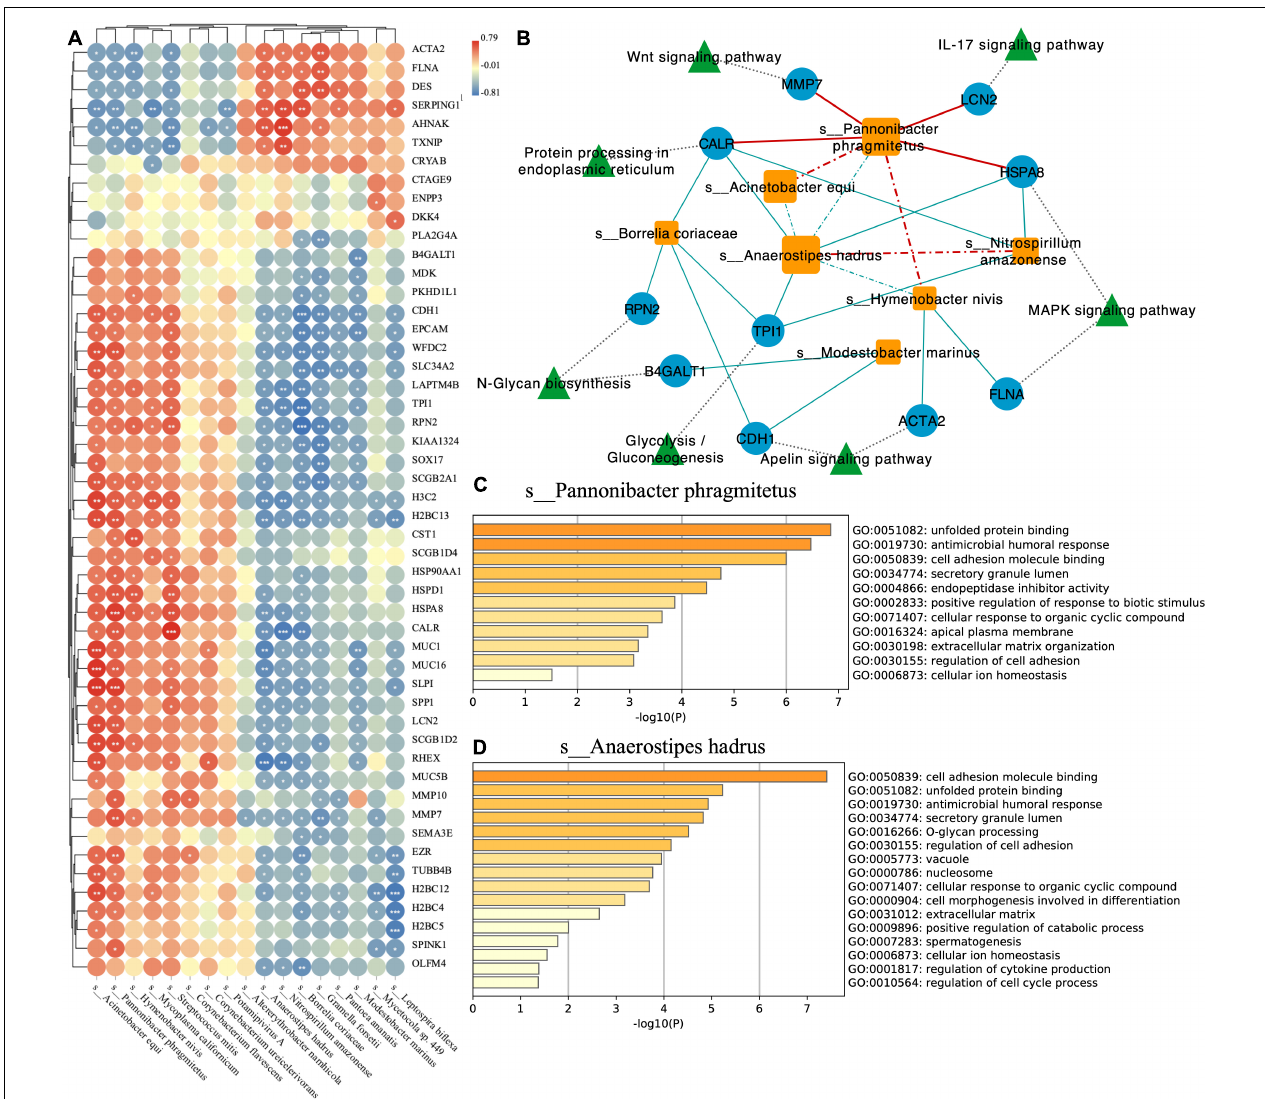
FIGURE 4 | (A) Correlation plot depicting top 50 loading genes and top 20 loading species correlations based on Spearman analysis (*** indicates p -value < 0.001, ** indicates p -value < 0.01, and * indicates p -value < 0.05). (B) Network visualizing the relationship between species, genes, and pathways. The solid line indicates the positive correlation (red) or negative (blue) relationship between the species and the gene. The dotted line indicates the positive correlation (red) or negative (blue) relationship between the species. Functional enrichment analysis of Pannonibacter phragmitetus (C) and Anaerostipes hadrus (D) .